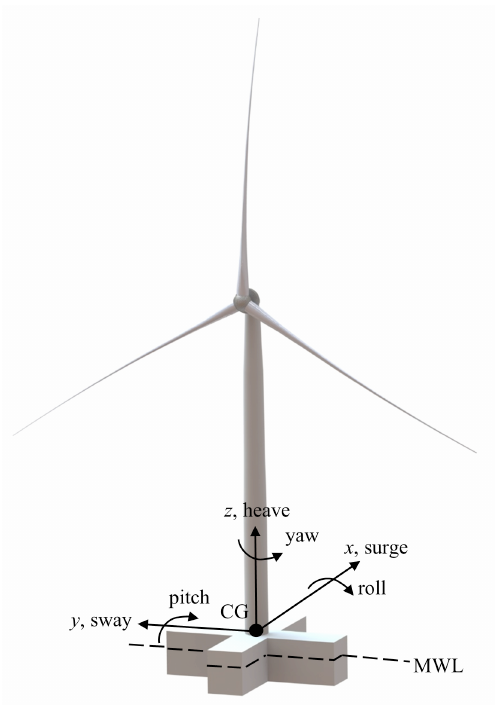
Figure 3. Coordinate